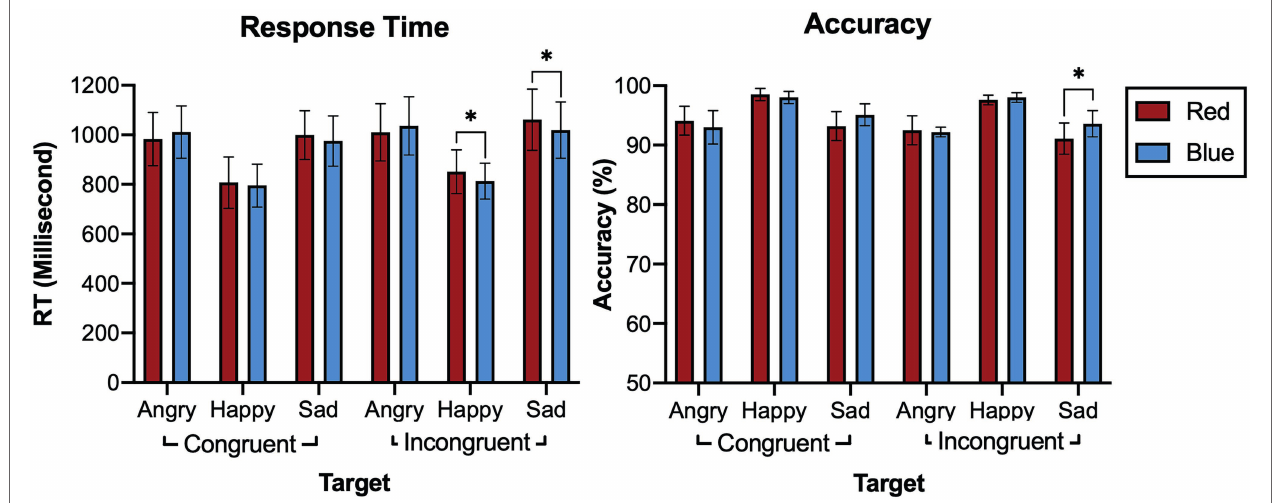
FIGURE 4 | Accuracy and response time for Experiment 2. Bars indicate 95% CIs of means. * p < 0.05; ** p < 0.01; and *** p <